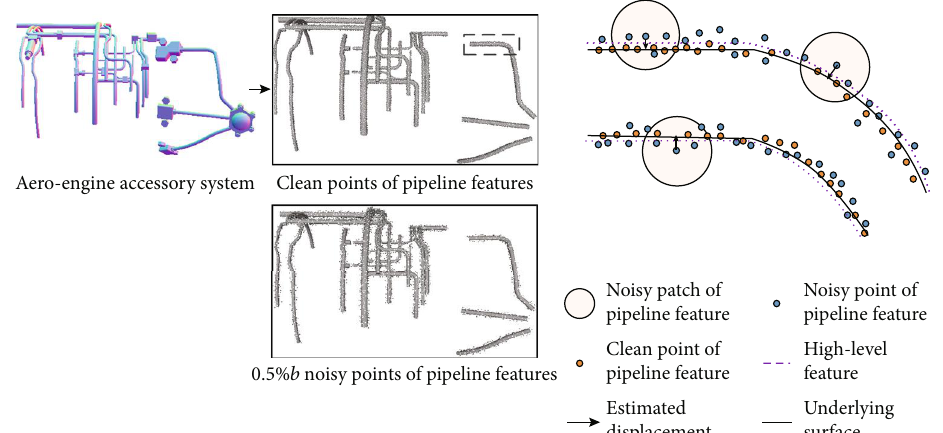
Figure 13: Illustration of pipeline feature denoising.